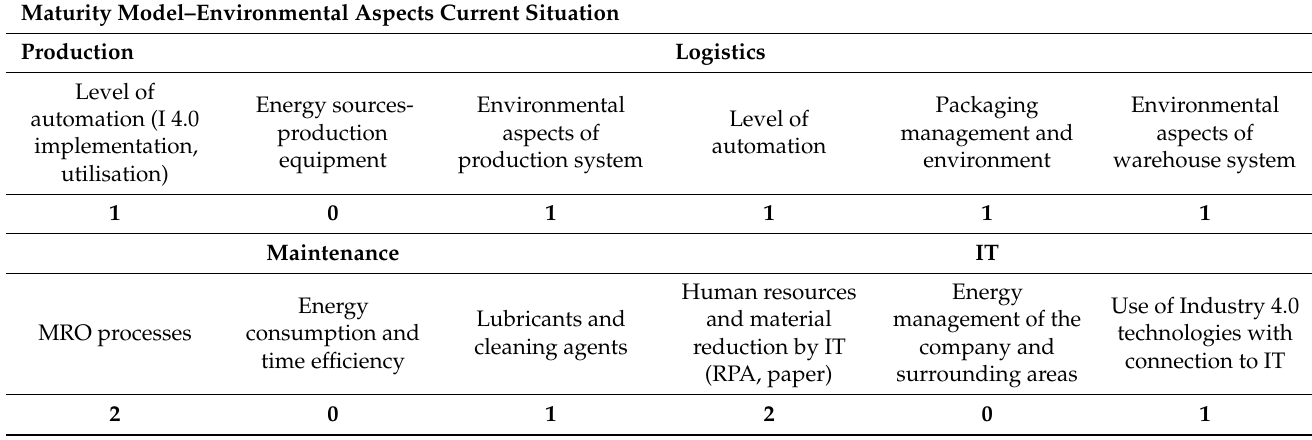
Table 4. Evaluation and classification of dimensions into